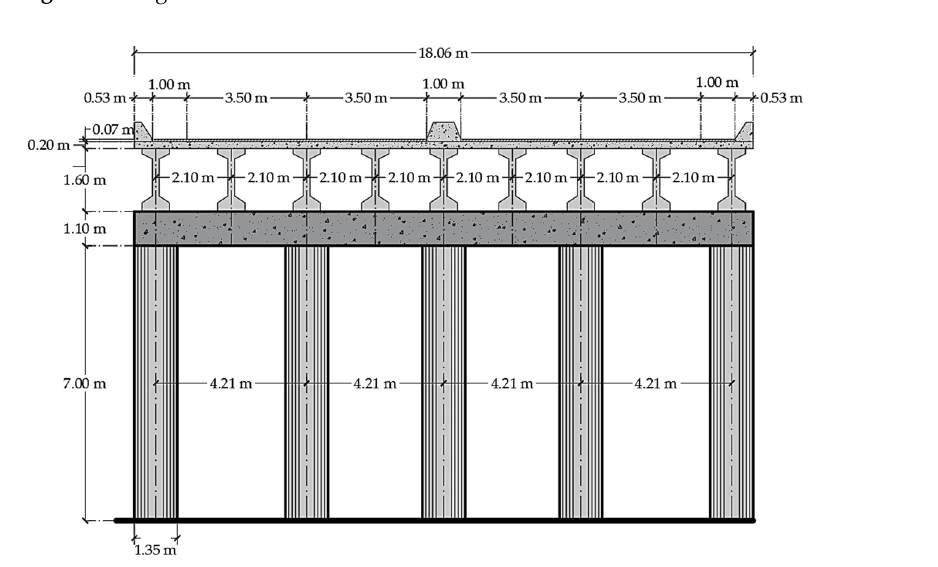
Figure 1. Longitudinal view.